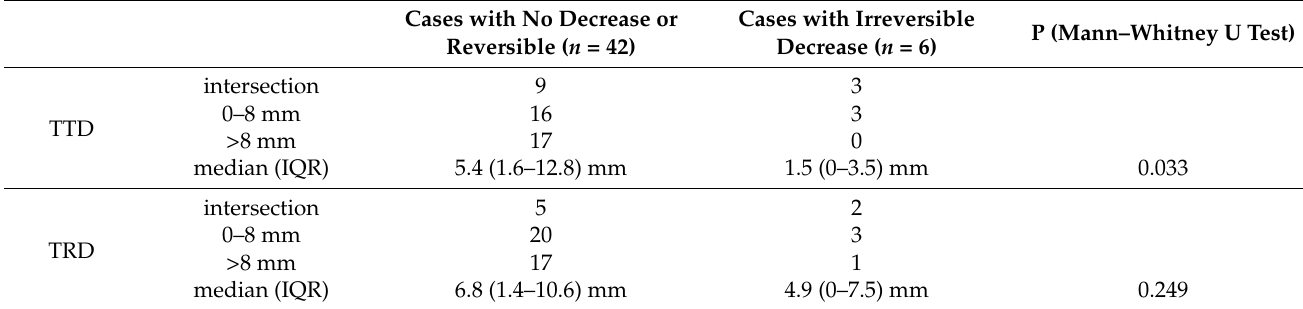
Figure 4. Box plot for the IOM results. The figure shows the TRD and TTD measurements for the two categories of MEP responses, namely patients with no or reversible decrease and patients with an irreversible decrease. Table 4. Correlation of TTD and TRD with the IOM results. Table 4. Correlation of TTD and TRD with the IOM